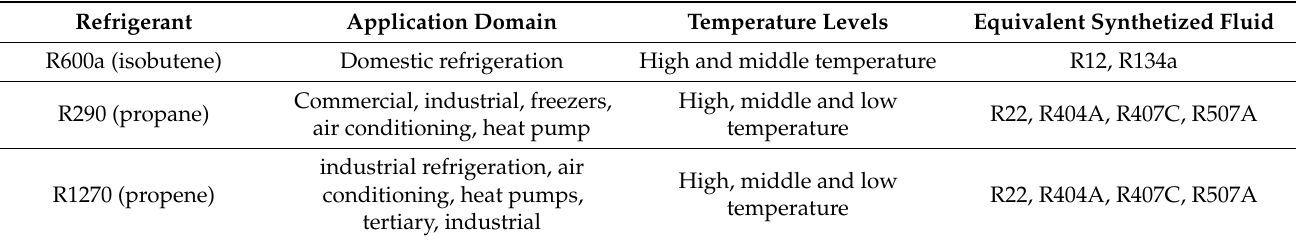
Table 5. Application domains of hydrocarbons.